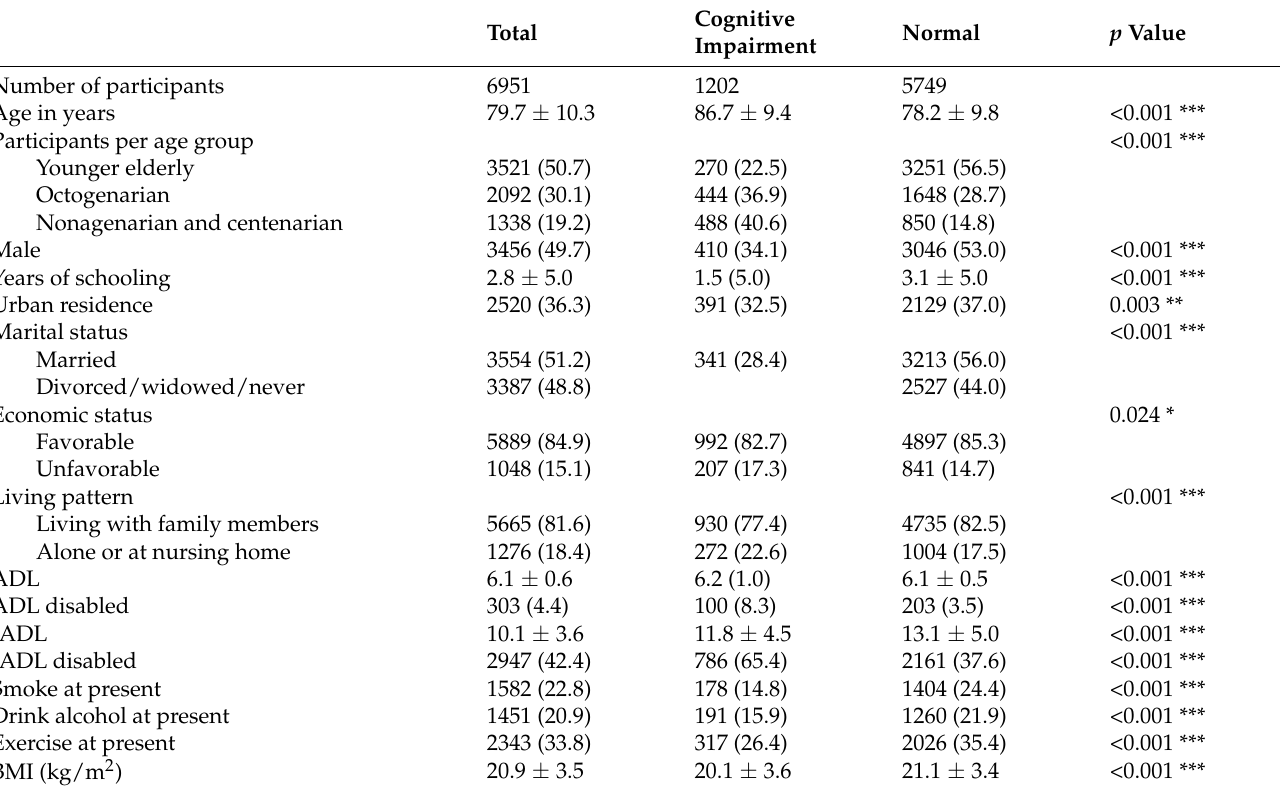
Table 1. Baseline characteristics of older people according to cognitive impairment